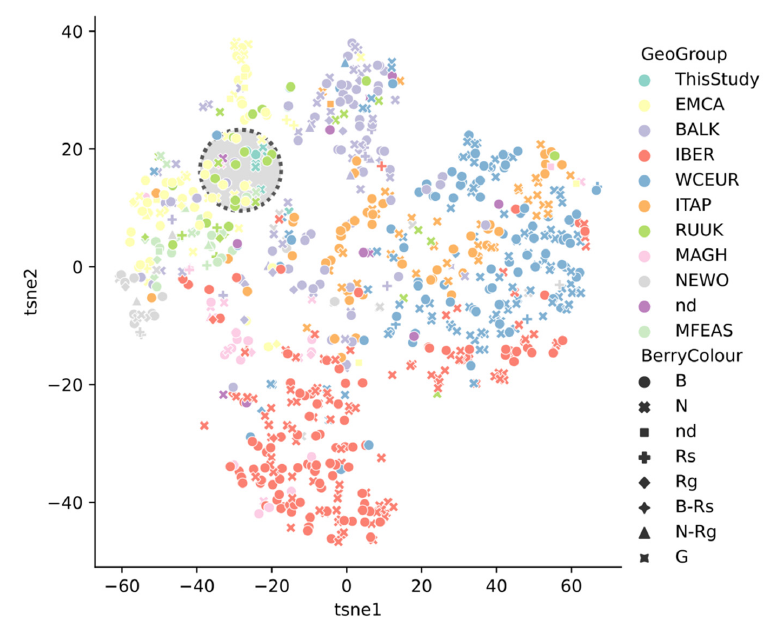
Figure 2. The tSNE visualization of genotype distances. Indigenous Don and Crimean specimens and related varieties are highlighted.